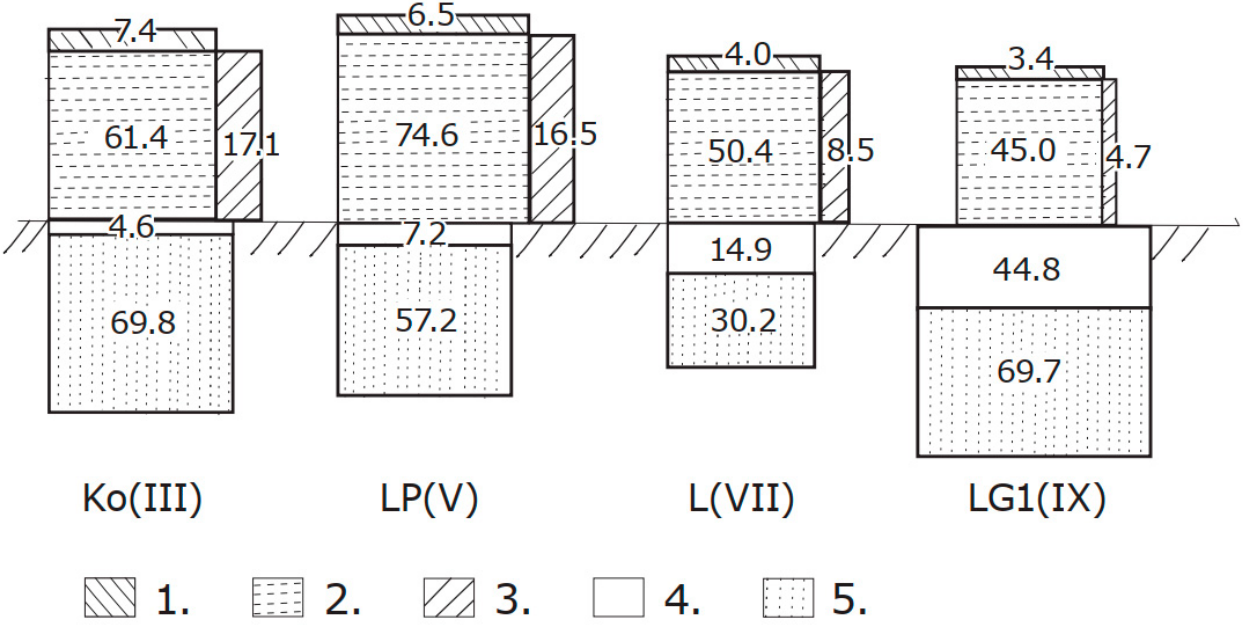
Figure 3. Graphical comparison of organic carbon sequestration capacities of four different types of forest ecosystems, in Mg OC ha − 1 . The studied ecosystems are Ko(III), LP(V), L(VII) and LG1(IX), respectively, with soil code and soil group number (in brackets); compartments of ecosystems 1—foliage of tree layer, 2—stems of tree layer, 3—branches of tree layer, 4—forest floor and 5—soil organic matter in mineral soil layers. Table 4. Annual increases (AI) of organic carbon (10 − 1 Mg OC ha − 1 year − 1 ) in different aboveground constituents of forest